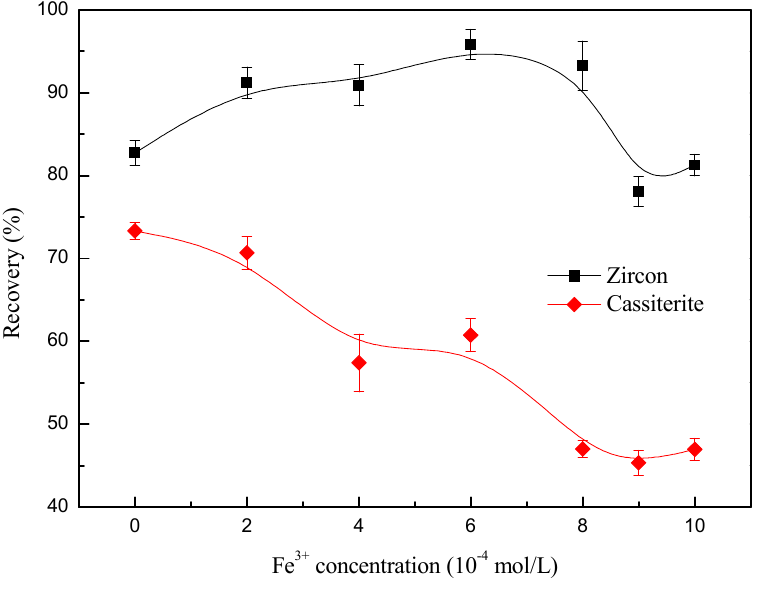
Figure 6. Flotation recoveries of zircon and cassiterite as a function of Fe 3+ concentration (NaOL: 4.0 × 10 − 4 mol/L; pH =